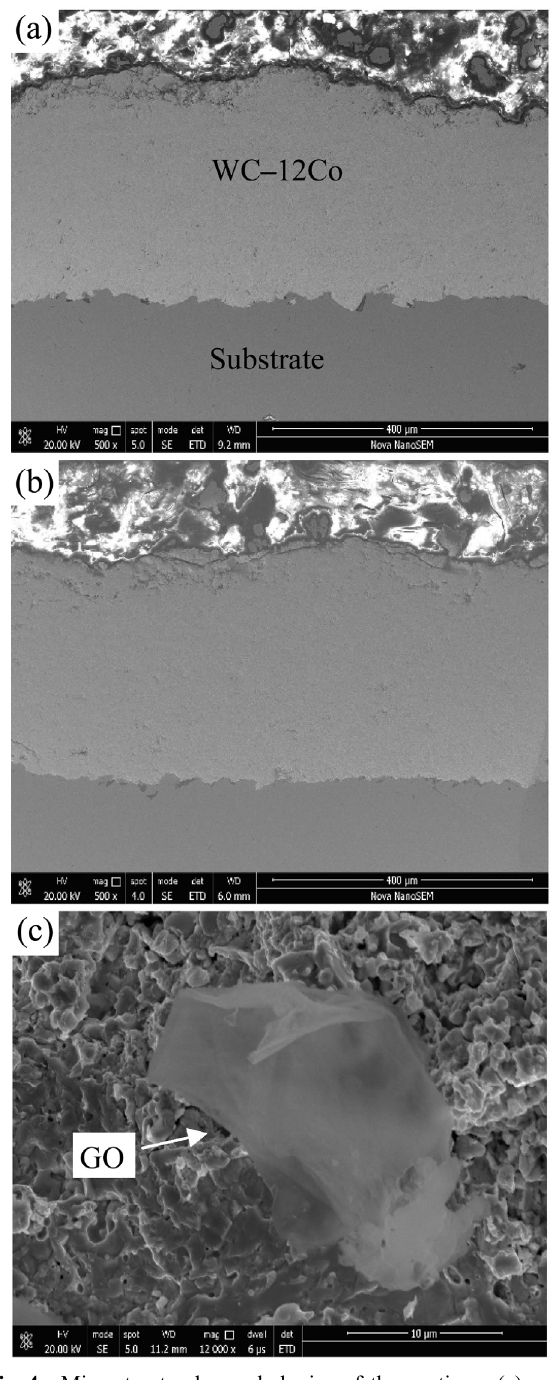
Fig. 4 Microstructural morphologies of the coatings: (a) cross section of the WC–12Co coating, (b) cross section of the GO/WC–12Co coating, and (c) fracture morphology of the GO/WC–12Co